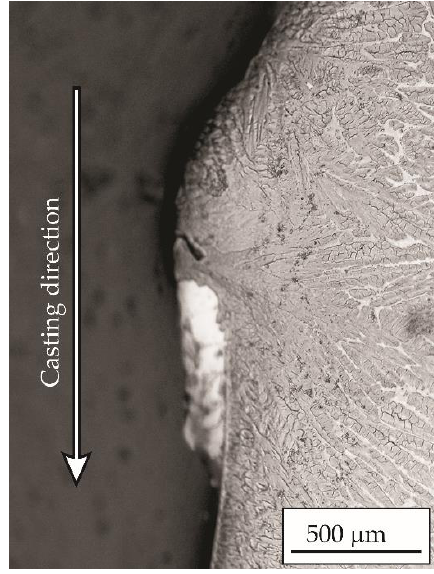
Figure 4. Copper particle below a primary witness mark on strand 3.